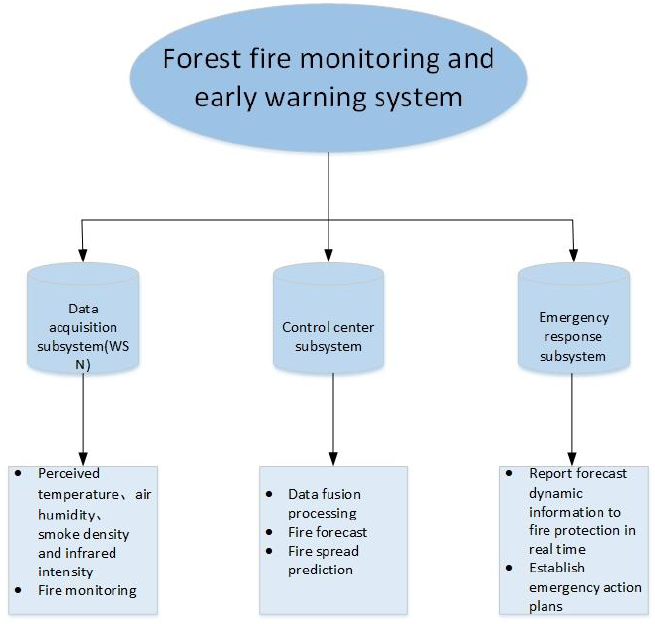
Figure 2. Forest fire monitoring and early warning system.